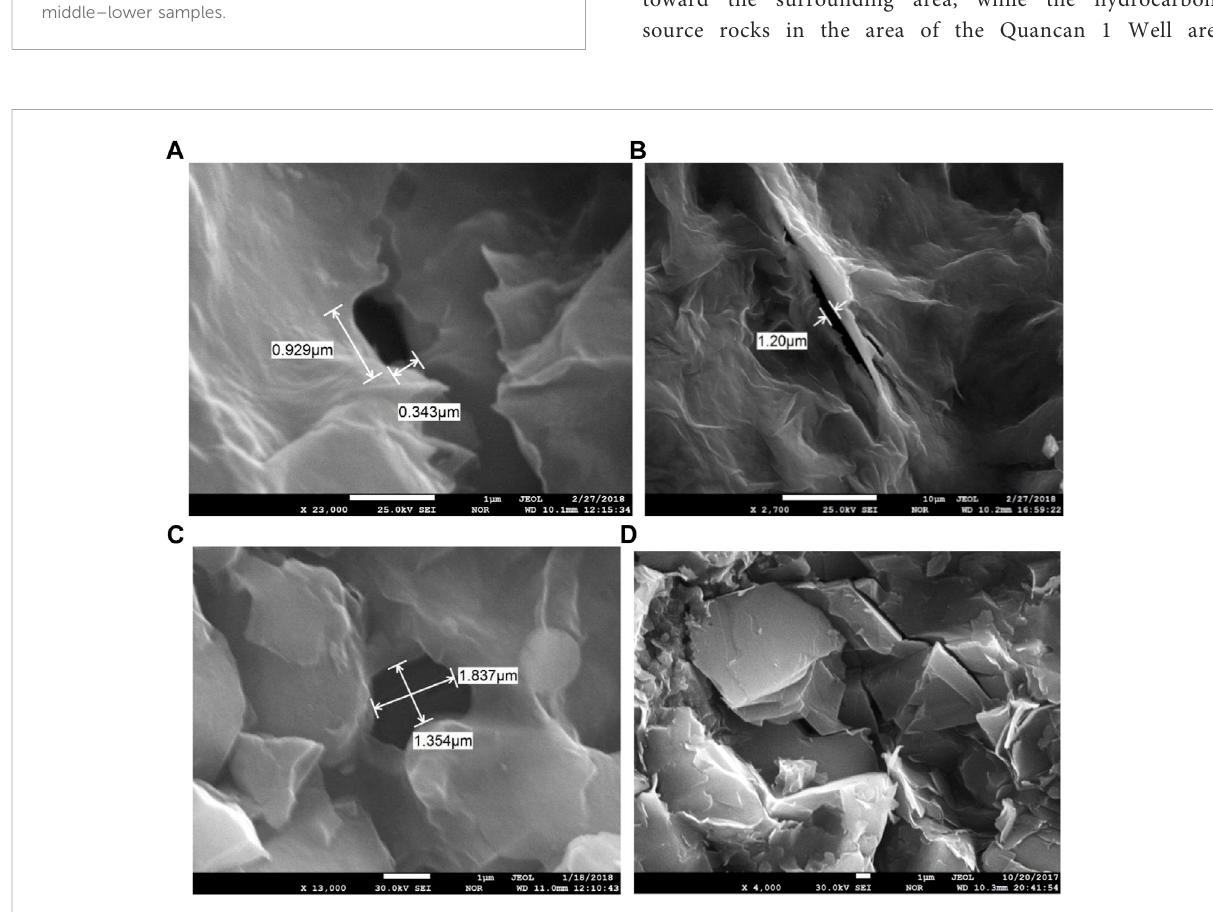
FIGURE 9 Pore type of all samples: (A) intergranular pore of shale reservoirs in the upper section; (B) intergranular gap of shale reservoirs in the upper section; (C) mold pore of sandstone reservoirs in the upper section; (D) granular minerals and intergranular microcracks of sandstone reservoirs in the upper